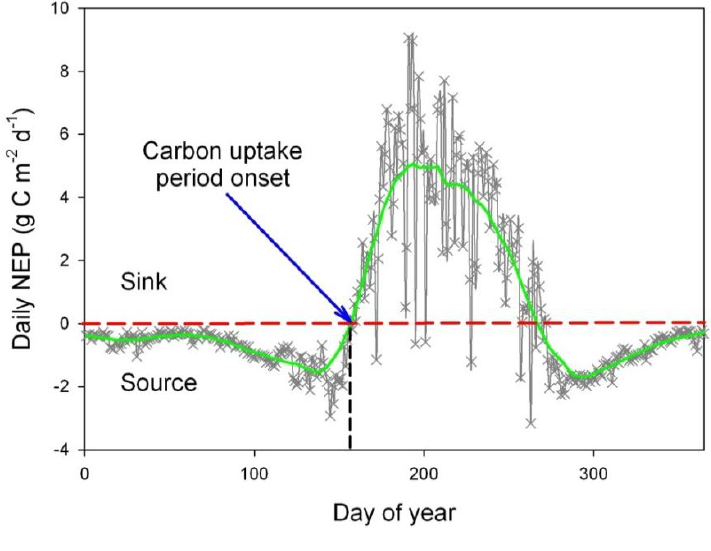
Figure 1. An example determination of the C-uptake period (CUP) onset using daily net ecosystem production (NEP) for SK-OA in 2009. CUP onset was designated as the first day on which a positive daily NEP of the smoothed curve was